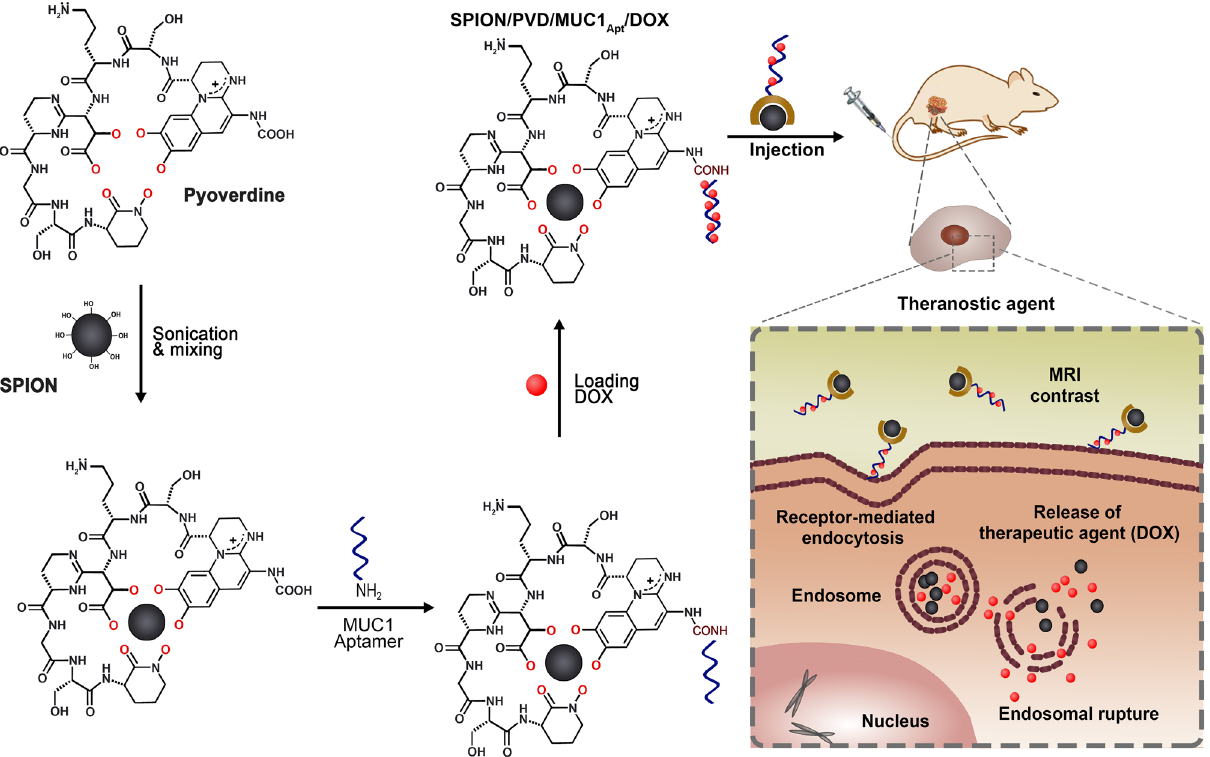
Figure 1. Schematic illustration of MUC1 Apt -based targeted system for delivery of SPION/PVD loaded with